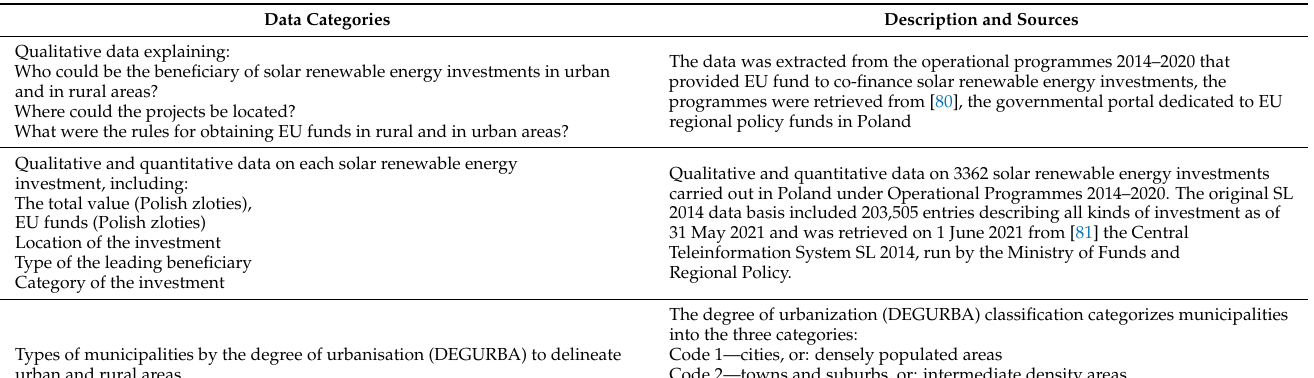
Table 1. Data categories and